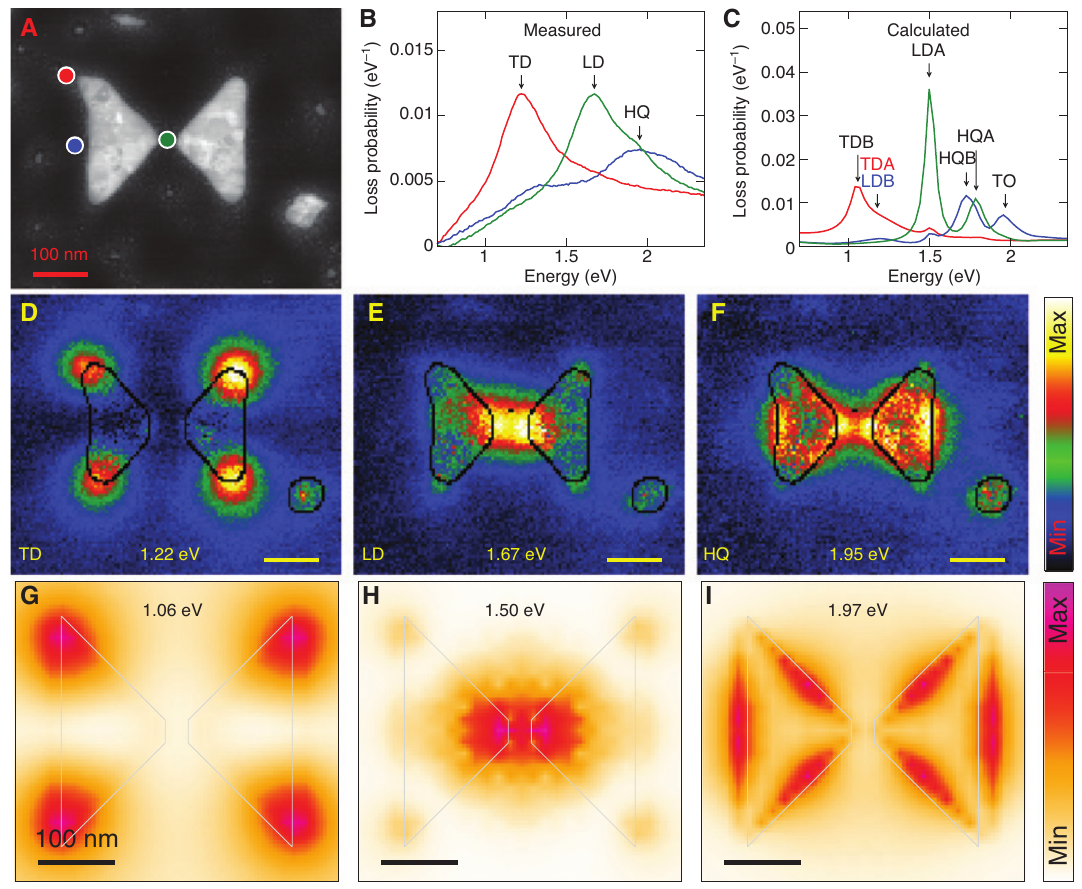
Figure 2: Bowtie antenna with the wing length L = 141 nm. (A) HAADF image. (B, C) EEL spectra recorded at specific points indicated by colour spots in panel A (the spectrum displayed by a specific colour corresponds to the spot of the same colour): (B) measured, (C) calculated. The labels of the peaks and modes are explained in the text. (D–F) Experimental energy-filtered maps of the loss intensity for (D) transverse dipolar mode (TD, E = 1.22 eV), (E) longitudinal dipolar mode (LD, E = 1.67 eV), (F) hexapolar–quadrupolar mode (HQ, E = 1.95 eV). (G–I) Calculated loss intensity maps at the energy of (G) transverse dipolar mode (1.06 eV), (H) longitudinal dipolar mode (1.50 eV), (I) hexapolar–quadrupolar mode (1.97 eV). Mode energies are indicated. Contours of the antennas are shown by black (experiment) or grey (calculations) lines. The length of the scale bars is 100